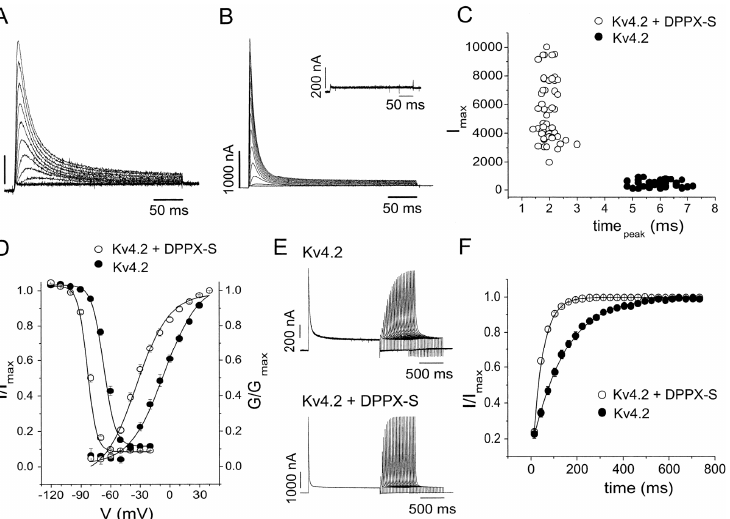
Figure 2. Effects of DPP6 on Kv4.2 ‐ Mediated A ‐ Type K + Currents. ( A , B ) A ‐ type K + currents recorded in Xenopus Oocytes with Kv4.2 expression alone ( A ) or Kv4.2 and DPP6 ( B ). ( C ) Peak current at +40 mV (I max ) and time ‐ to ‐ peak (time peak ) for the currents recorded with Kv4.2 alone or Kv4.2 plus DPP6. ( D ) Normalized conductance ‐ voltage (G/G max ) and steady ‐ state inactivation (I/I max ) curves for A ‐ type currents with Kv4.2 alone or Kv4.2 plus DPP6. The curves were fitted with Boltzmann functions. ( E ) Recovery from inactivation of the A ‐ type currents with Kv4.2 alone or Kv4.2 plus DPP6. Shown are the currents recorded during test pulses to 50 mV following a test pulse to the same voltage separated by increasing time intervals at − 110 mV. ( F ) Time course of the recovery from inactivation of the A ‐ type currents with Kv4.2 alone or Kv4.2 coexpressed with DPP6 at ‐ 110 mV. The curves were fitted with a single exponential. Reprinted with permission from Nadal et al., 2003 [10], Elsevier.